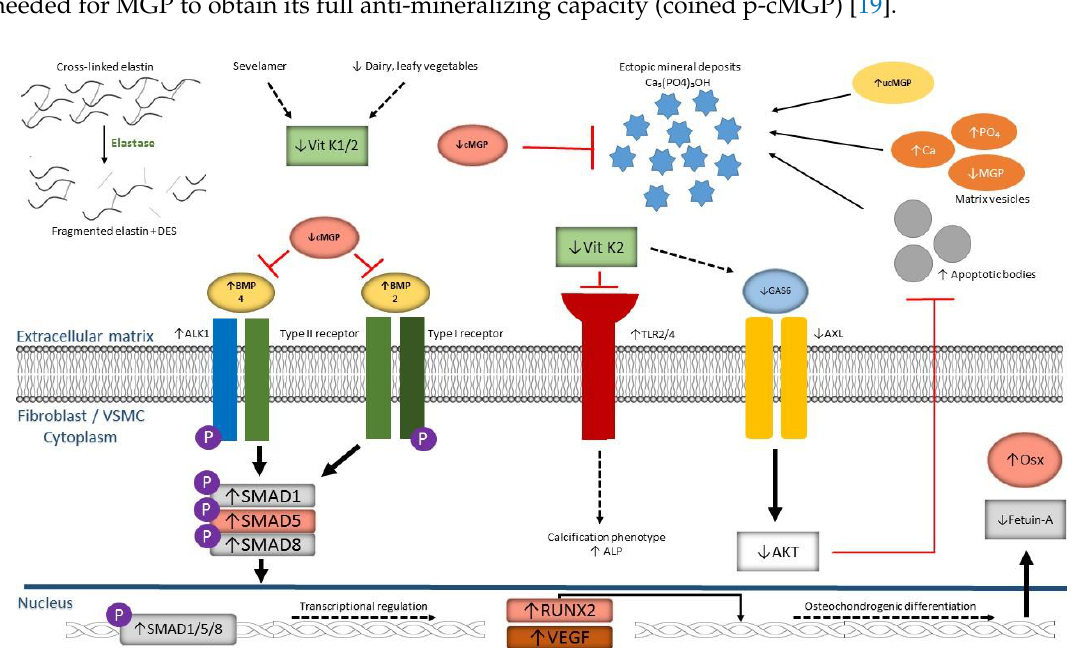
Figure 2. Schematic representation of molecular alterations in the extracellular matrix and cytoplasm of fibroblasts/vascular smooth muscle cells contributing to ectopic mineralization, focusing on vitamin K and related compounds. AKT: AK strain transforming. ALK1: activin receptor-like kinase 1. ALP: alkaline phosphatase. AXL: AXL receptor tyrosine kinase. BMP: bone morphogenetic protein. Ca: calcium. Ca 5 (PO 4 ) 3 OH: calcium hydroxyapatite. DES: (iso)desmosine. GAS6: growth arrest specific-6. (u)cMGP: (un)carboxylated matrix gla protein. OSX: osterix. PO 4 : phosphate. RUNX2: